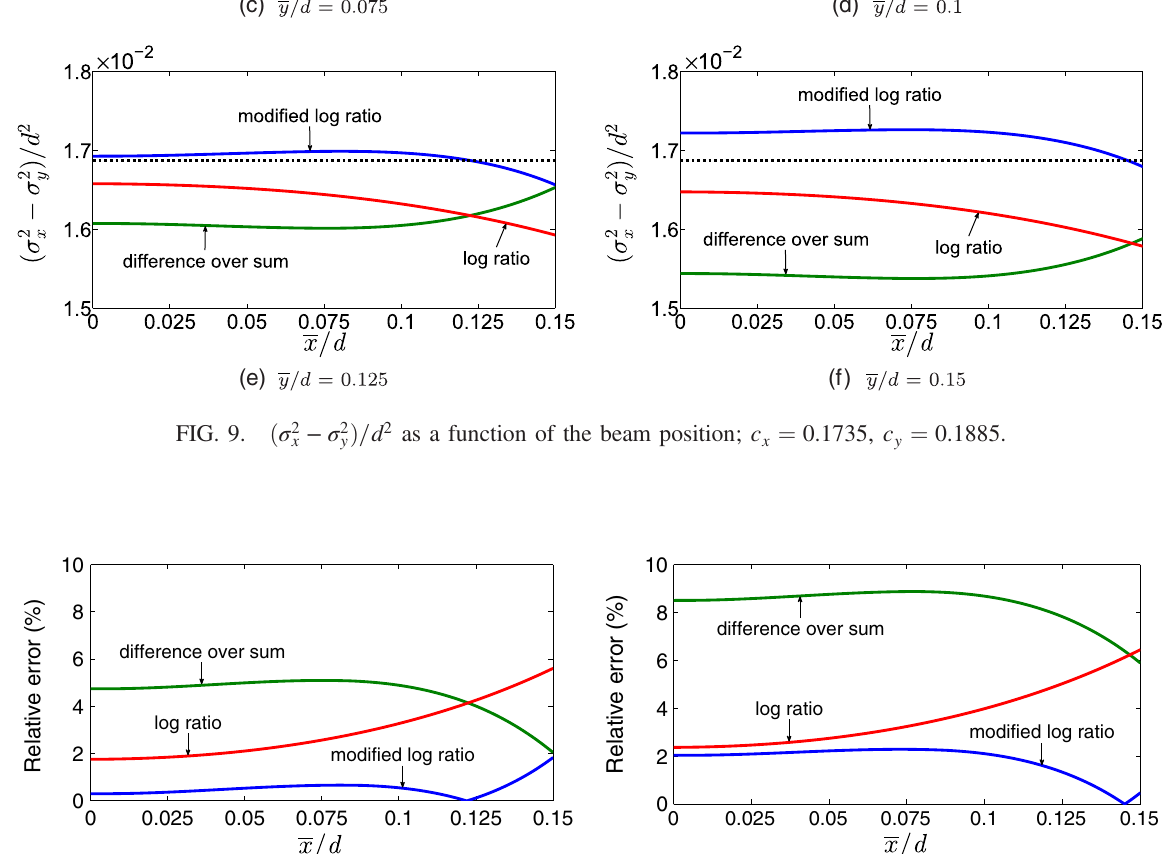
FIG. 10. Absolute value of the relative deviation of the calculated values of ð σ 2 x − σ 2 y Þ =d 2 from its ideal value as a function of ¯ x=d for a fixed value of ¯ y=d